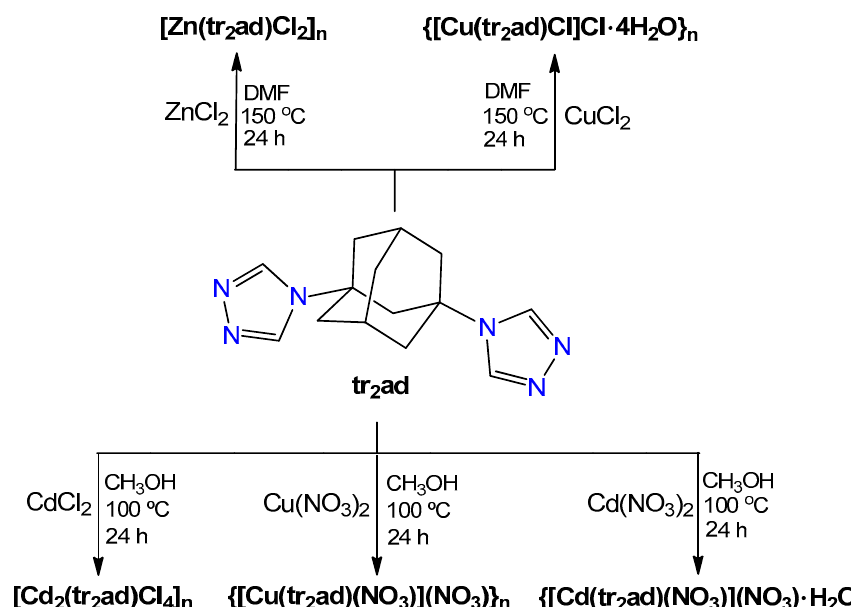
Scheme 2. Synthetic paths for the formation of the tr 2 ad-based coordination polymers (CPs) described in this work.